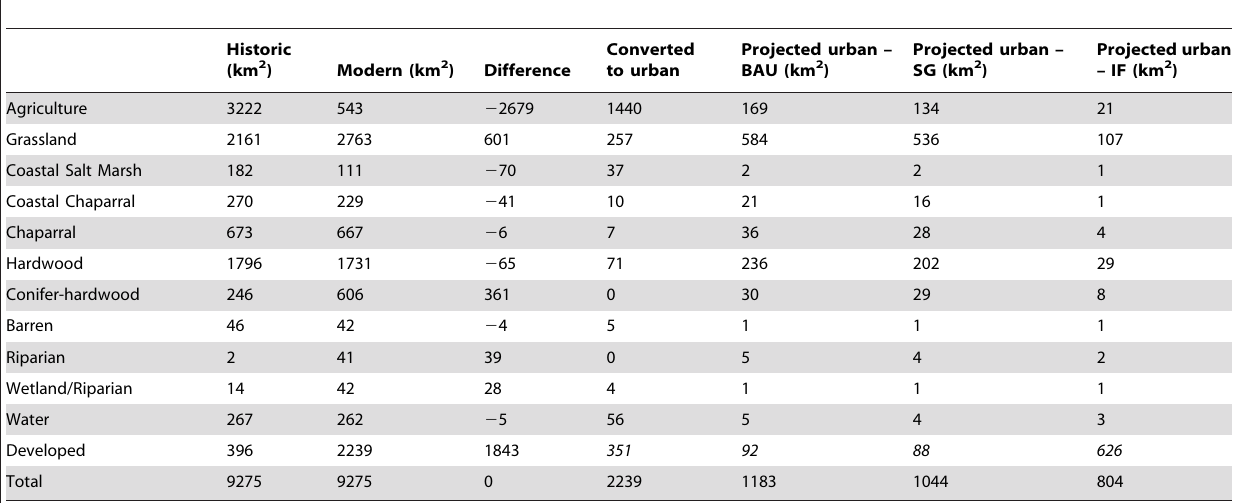
Table 1. Area (km 2 ) covered by each landcover class in each time period and projected urban growth within current vegetation types in the Bay